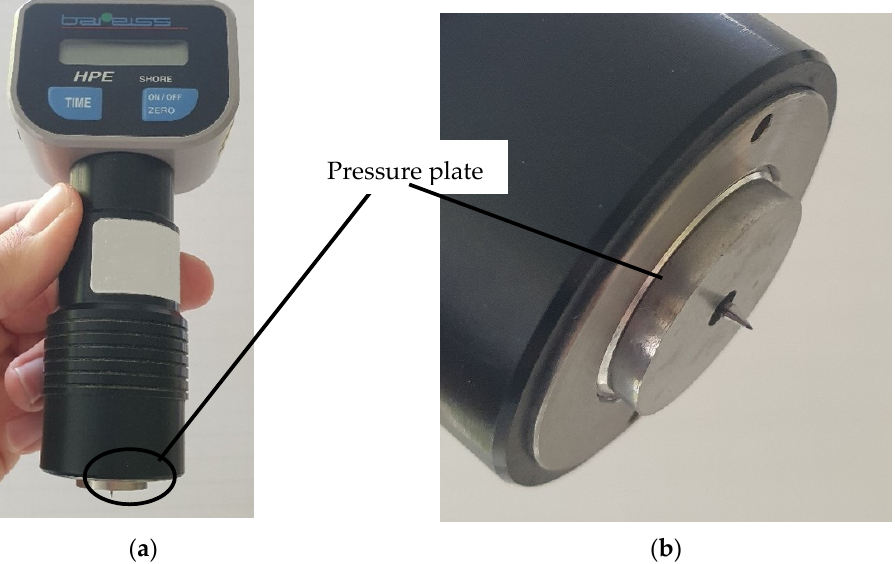
Figure 9. Shore D durometer according to [43], ( a ) shore D durometer, ( b ) detail of the pressure plate.